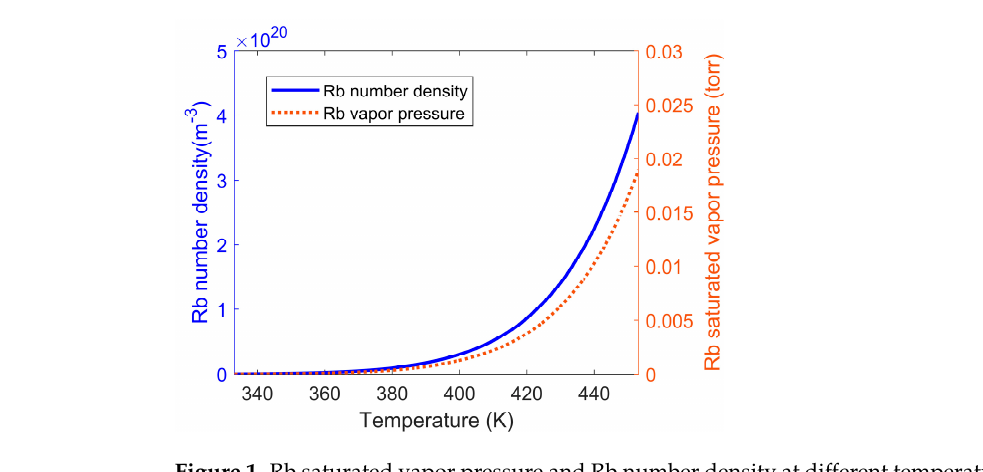
Figure 1. Rb saturated vapor pressure and Rb number density at different temperatures, as calculated from Equations (3) and (5).